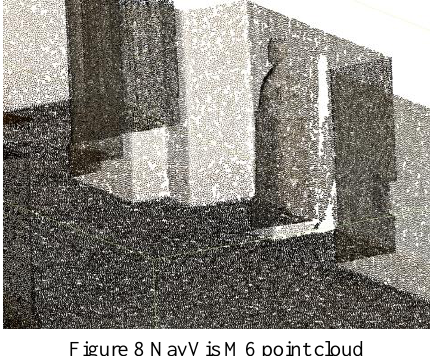
Figure 8 NavVis M6 point cloud